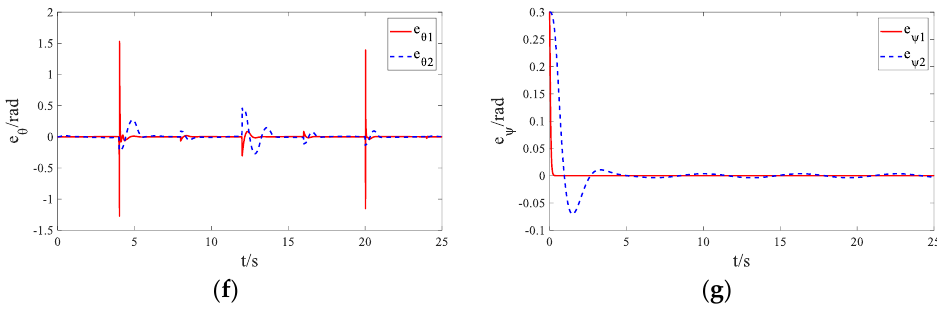
Figure 7. Comparison of the trajectory − tracking errors based on ESO − SMC and ADRC under disturbance: ( a ) 3D effect; ( b ) x trajectory; ( c ) y trajectory; ( d ) z trajectory; ( e ) roll angle; ( f ) pitch angle; and ( g ) yaw angle.